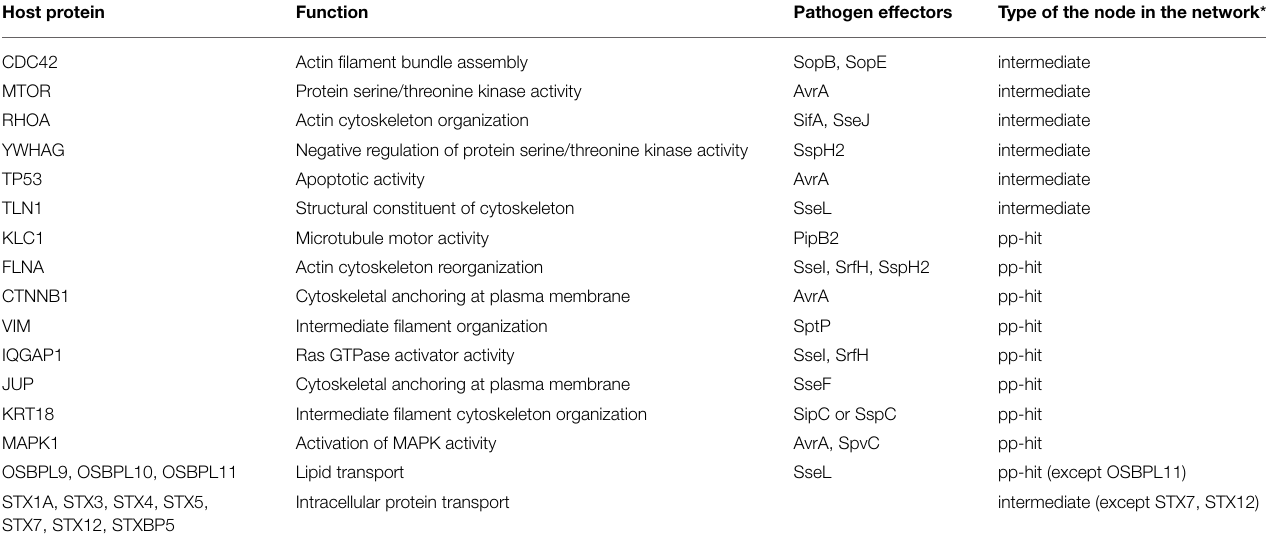
TABLE 1 | Targets of Salmonella effectors in the reconstructed